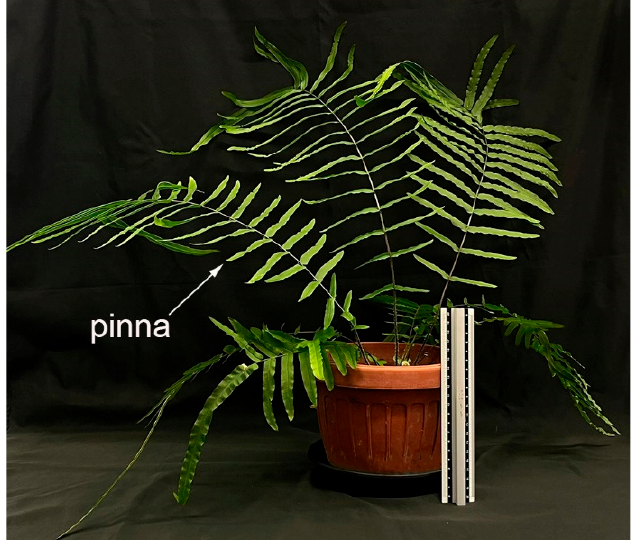
Figure 1. A P. vittata plant grown in naturally As-rich soil under greenhouse conditions. The arrow indicates the pinna collected for preparing pinna powder.